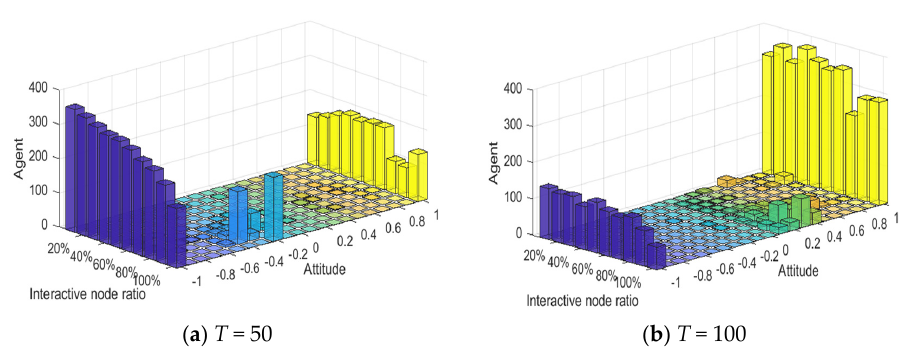
Figure 25. Evolution diagram of group attitude under different interaction node proportions. ( a ) T = 50; ( b ) T = 100.